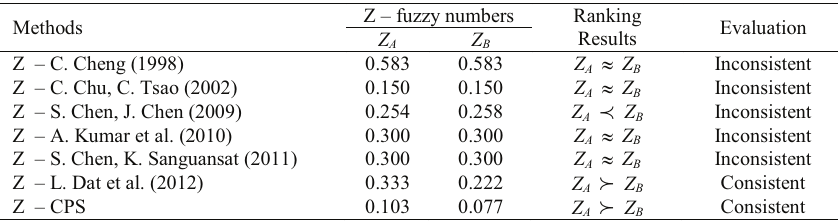
Table 1.Comparative results using Z – fuzzy numbers of Case